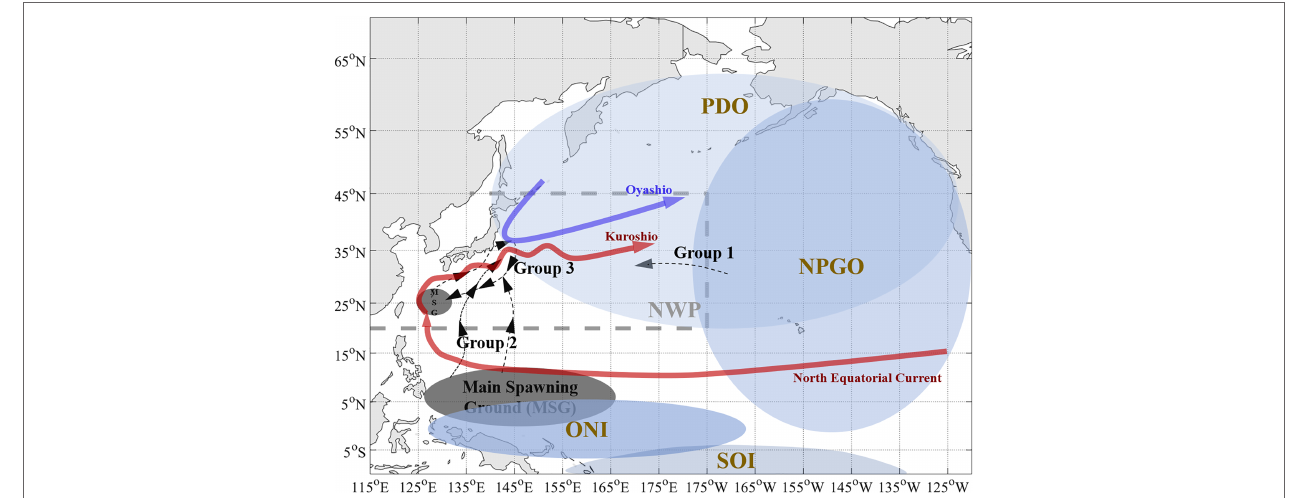
FIGURE 1 | Schematic of the study area in the north Pacific with main currents, climate background, and migration routes of skipjack tuna inside. The study area (Northwest Pacific, NWP) is surrounded by the grey-dotted lines and the mainland coast of countries, including China, Korea, South Korea, Japan, and Russia. Blue ellipses show the defined scope of climate indices with different brightness. The main spawning grounds (MSG) of SKJ in the western Pacific and potential migration routes of three groups of skipjack tuna in the NWP are indicated with black arrow lines and grey ellipses, respectively (Arai et al., 2005; Kiyofuji et al., 2019; Tawa et al., 2020; Moore et al., 2020). The paths of Kuroshio Current with its origin (North Equatorial Current) and extension and Oyashio Current are shown by red and dark blue arrow lines,